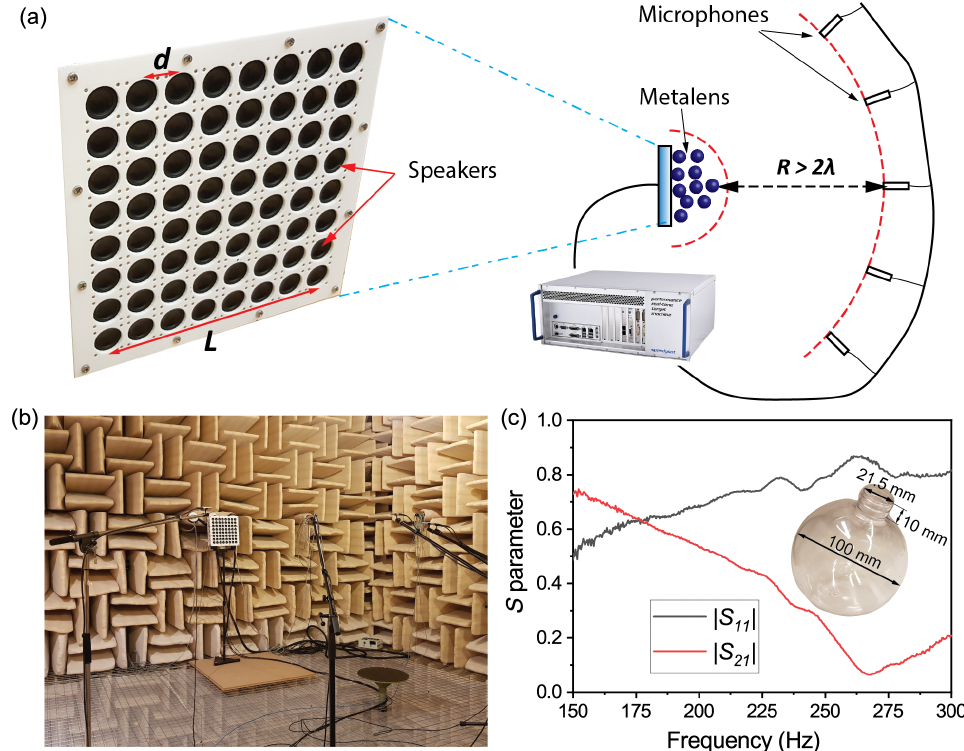
FIG. 3. Experimental testing of subwavelength acoustic imaging from far field. (a) Scheme of the experimental setup for the subwavelength image reconstruction and recognition. The acoustic image is drawn on a source (left inset), which is composed of speakers placed in a lattice with a period of d ¼ 33 . 3 mm (approximately λ 0 = 41 ) with the overall side length of L ¼ 268 mm (approximately λ 0 = 5 ), where λ 0 is the minimum measured wavelength. The amplitude of the excitation of each speaker is controlled by a Speedgoat real-time target machine, which also records the signals coming from four microphones placed in the far field. (b) Photo of the experimental setup in the anechoic chamber. (c) The scattering ( S ) parameters of a Helmholtz resonator (a plastic ball with a bottleneck as shown in the inset photo) that comprises the locally resonant metalens and has the resonance frequency f r ≈ 268